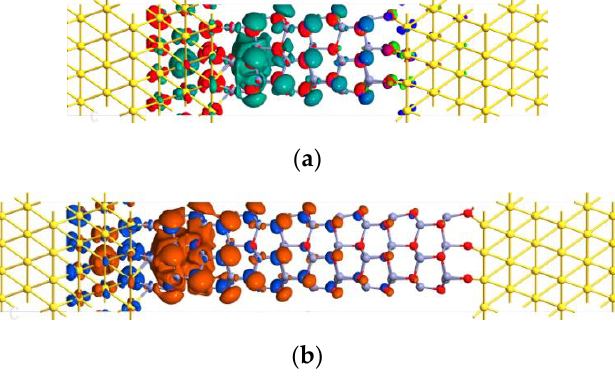
Figure 3. Density of states (DOS) of the scattering regions and projected density of states (PDOS) of the n -ZnONR (( a ): 4-ZnONR, ( b ): 6-ZnONR, ( c ): 8-ZnONR, ( d ): 10-ZnONR) for different lengths at equilibrium, and the zero of the energy is set to Fermi level.